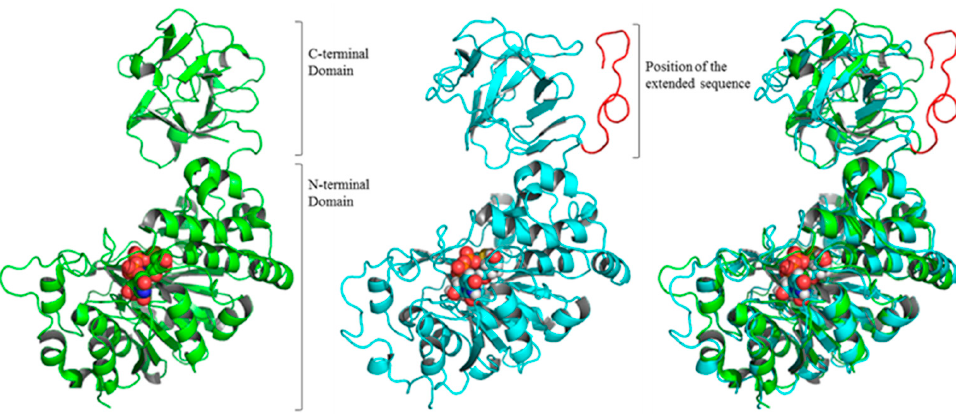
Figure 3. Predicted structures of wild-type and mutant GALNT2 . The image depicts the X-ray structure [27] of wild-type GALNT2 ( left ), predicted structure of mutated GALNT2 ( center ), and an overlay of the structures of wild-type and mutated GALNT2 ( right ). The extended sequence region is shown in red. The UDP-GalNAc molecule is represented by the CPK model. The structural alignment and visualization were created using PyMOL (Schrödinger LLC.).